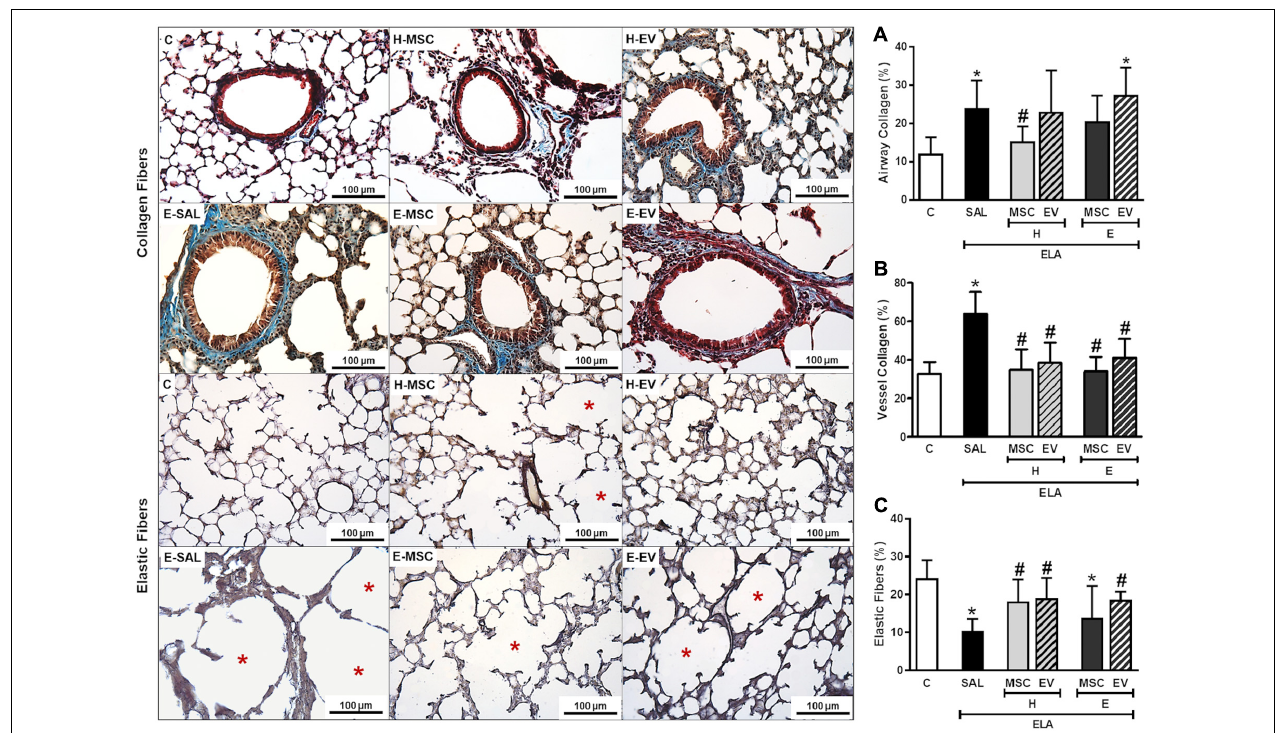
FIGURE 9 | Effects of H-MSCs, E-MSCs, H-EVs or E-EVs treatments on the remodeling process. Left panels: representative photomicrographs of lung parenchyma stained with Masson’s trichome staining collagen fibers in airways, (A) ; walls of blood vessels in interlobular septa, (B) and Weigert’s resorcin fuchsin elastic fibers in alveolar septa, (C) . Note that blood vessels are highlighted by red arrowheads, elastic fibers by black arrowheads, and hyperinflated areas by red asterisks. C: intratracheal instillation of 50 µ L of saline; ELA: intratracheal instillation of 0.2 UI of pancreatic porcine elastase (PPE); SAL: intravenous injection of 50 µ L of saline; H-MSCs: 1 × 10 6 bone marrow mesenchymal stromal cells obtained from healthy donor; E-MSCs: 1 × 10 6 bone marrow mesenchymal stromal cells obtained from emphysematous donor; H-EVs: extracellular vesicles derived from 1 × 10 6 bone marrow mesenchymal stromal cells obtained from healthy donor; E-EVs: extracellular vesicles derived from 1 × 10 6 bone marrow mesenchymal stromal cells obtained from emphysematous donor. Right panels: Data are expressed as mean + SD of 5–7 animals/group. *vs. C group ( p < 0.05). # Vs. ELA-SAL group ( p <